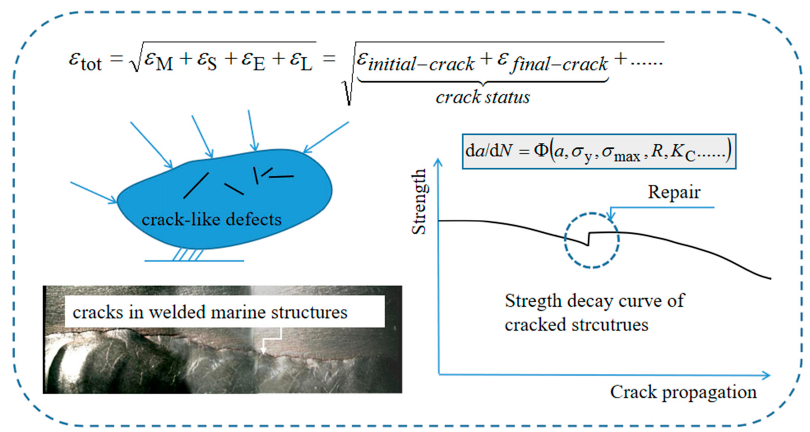
Figure 1. Schematic of the unified fatigue life prediction method.